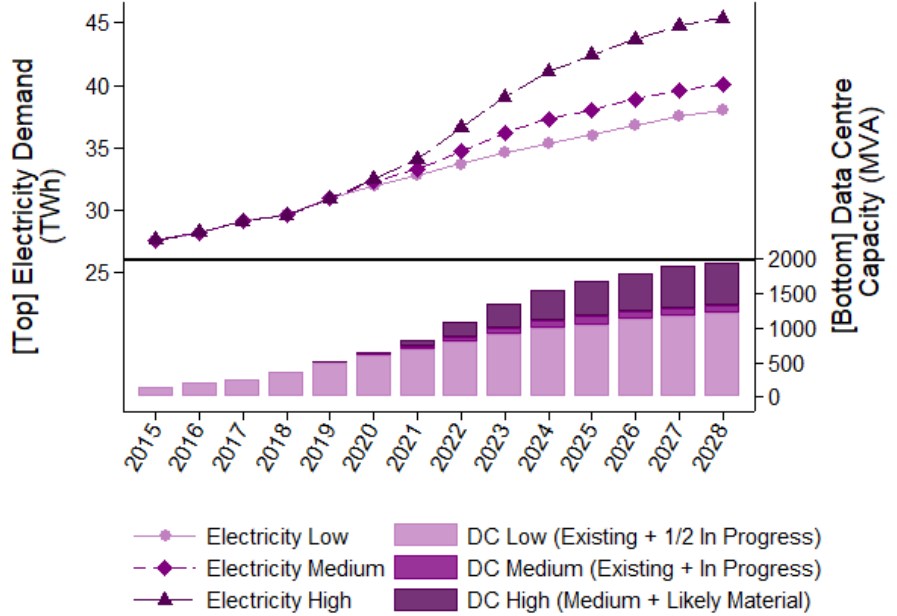
Figure 1. Author’s illustration based on values from EirGrid [53] forecast of electricity demand and data centre capacity.